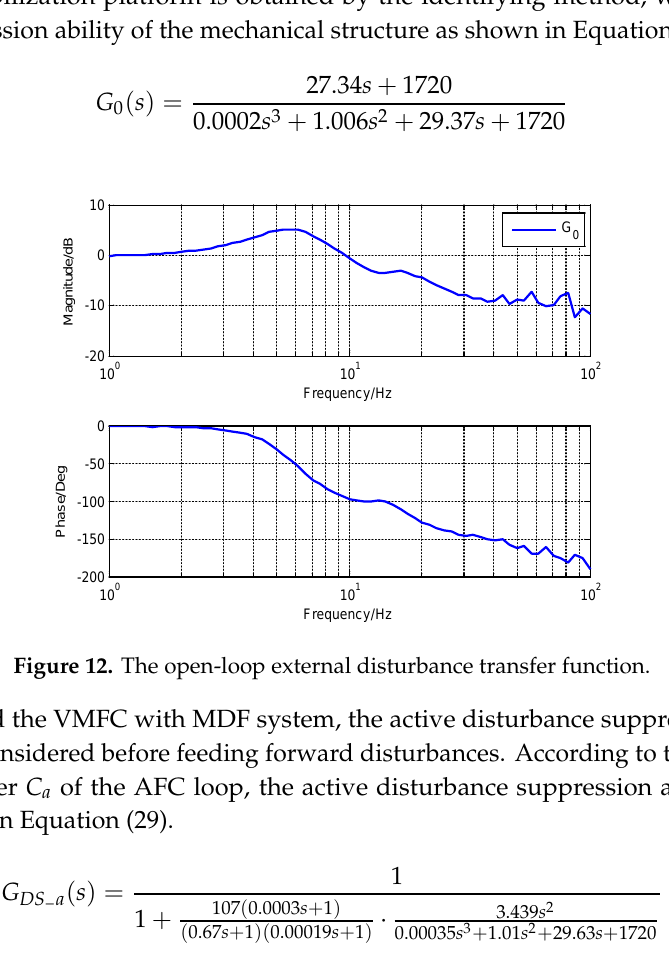
Figure 11. The comparison of disturbance suppression abilities between the MFC and VMFC.